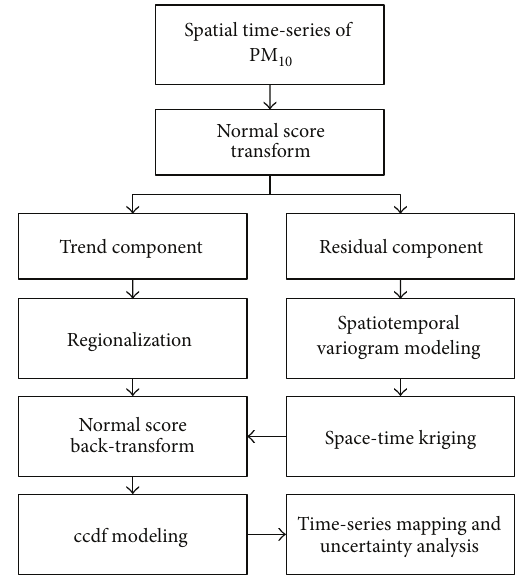
Figure 2: Work flows for multi-Gaussian space-time kriging pre- sented in this